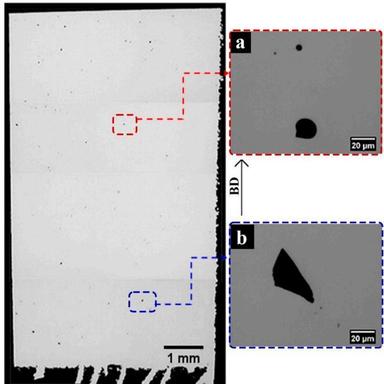
Light optical micrographs taken in the build direction of a polished asbuilt sample, showing different types of pores: a) trapped gas and b) incomplete melting.